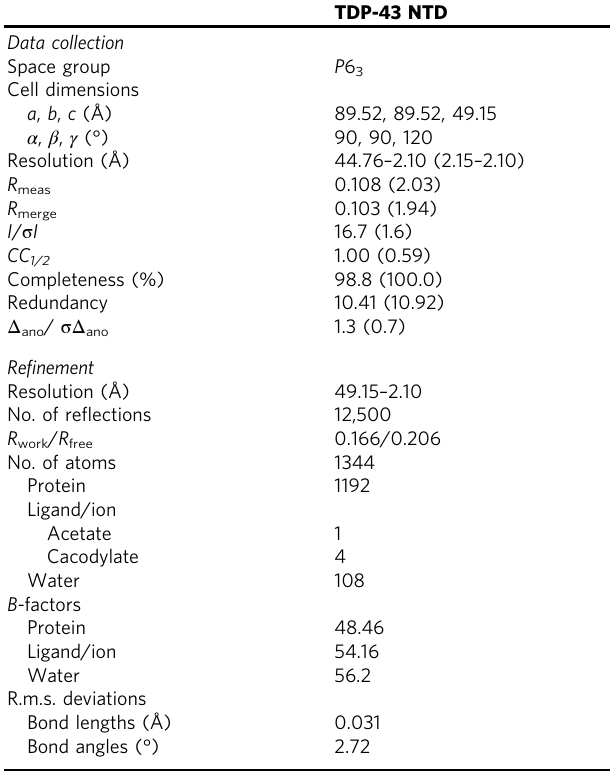
Table 1 Data collection and re fi nement